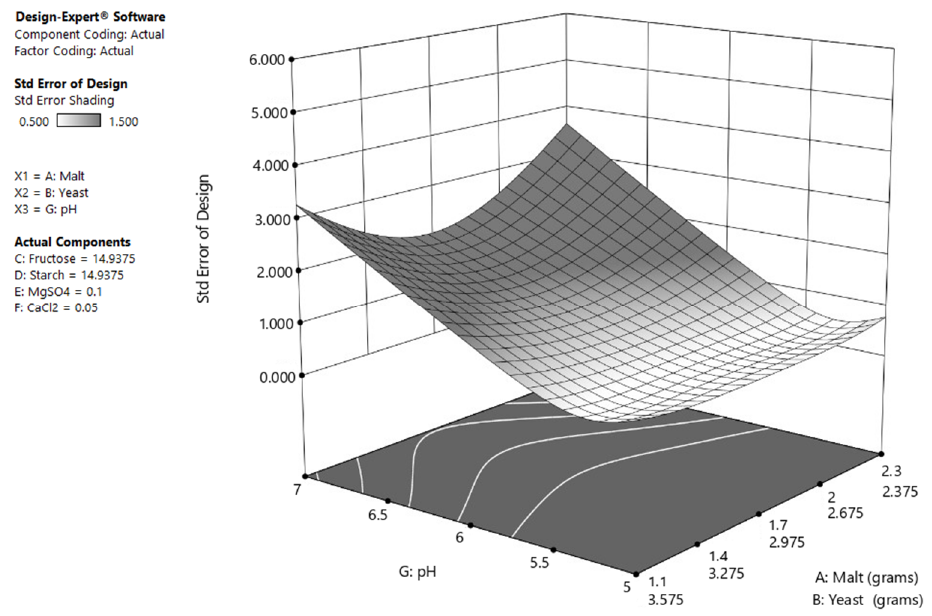
Figure 2. The 3D mix-process graph of the standard error of design.